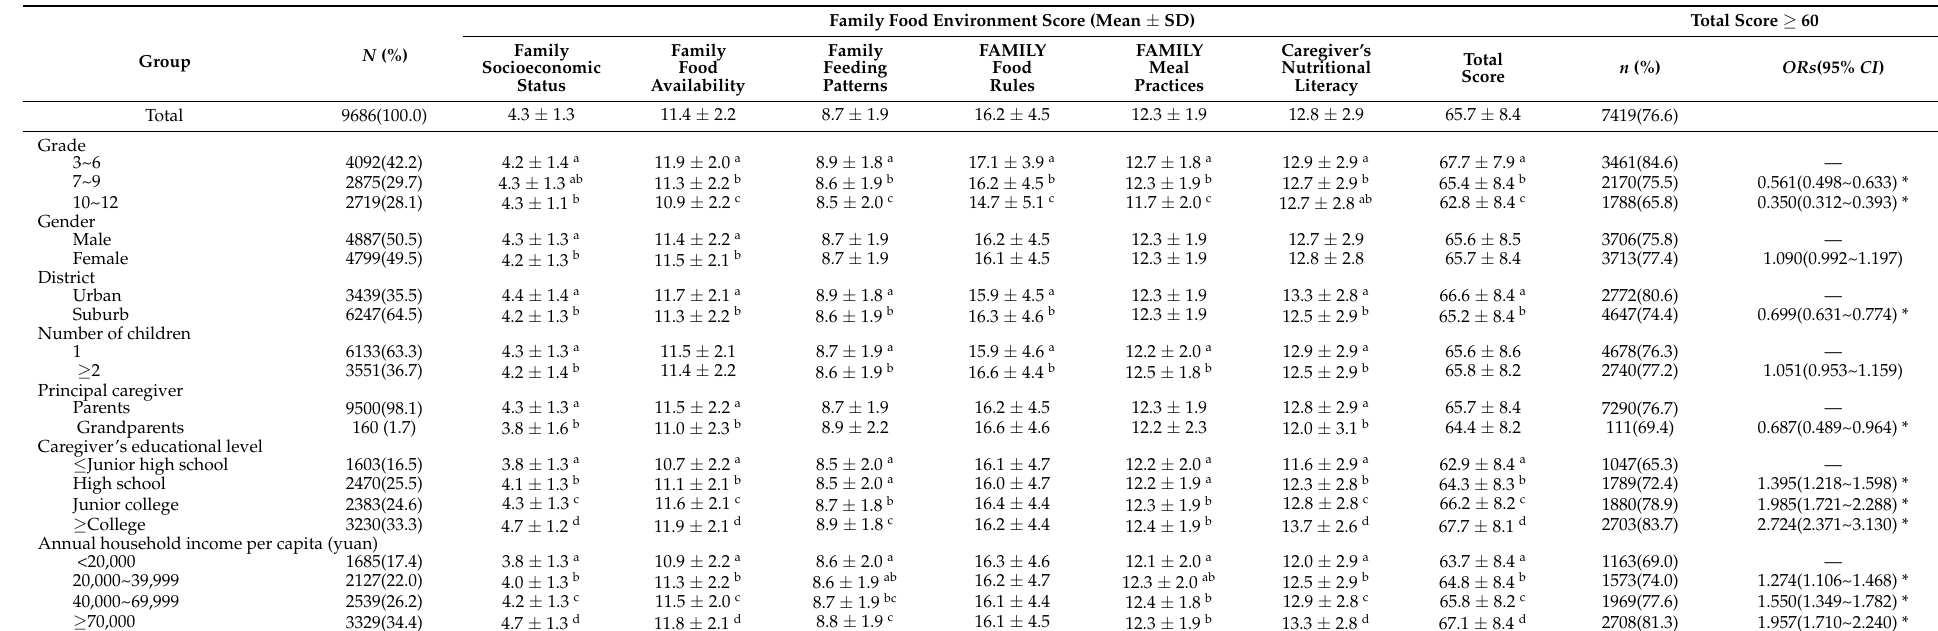
Table 1. Individual and household demographic characteristics of family food environments.